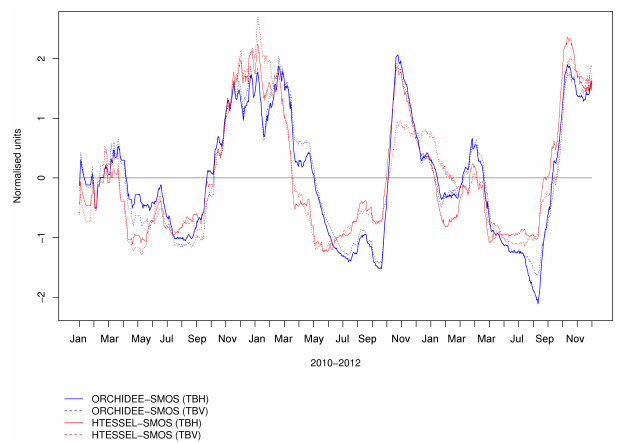
Figure 5. Temporal evolution of the expansion coefficients corre- sponding to the first EOF variation mode of the TB errors (OR- CHIDEE vs. SMOS and H-TESSEL vs. SMOS) over the Iberian Peninsula. Values have been normalized using the standardization method. TBH and TBV correspond to the horizontal and vertical polarizations,